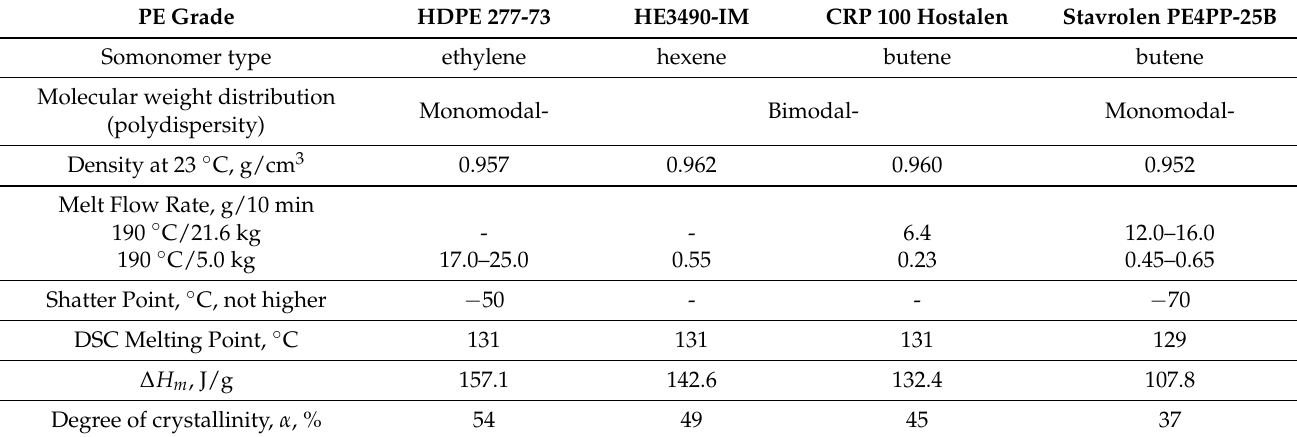
Table 1. Main physico-chemical characteristics according to manufacturers’ data sheets and